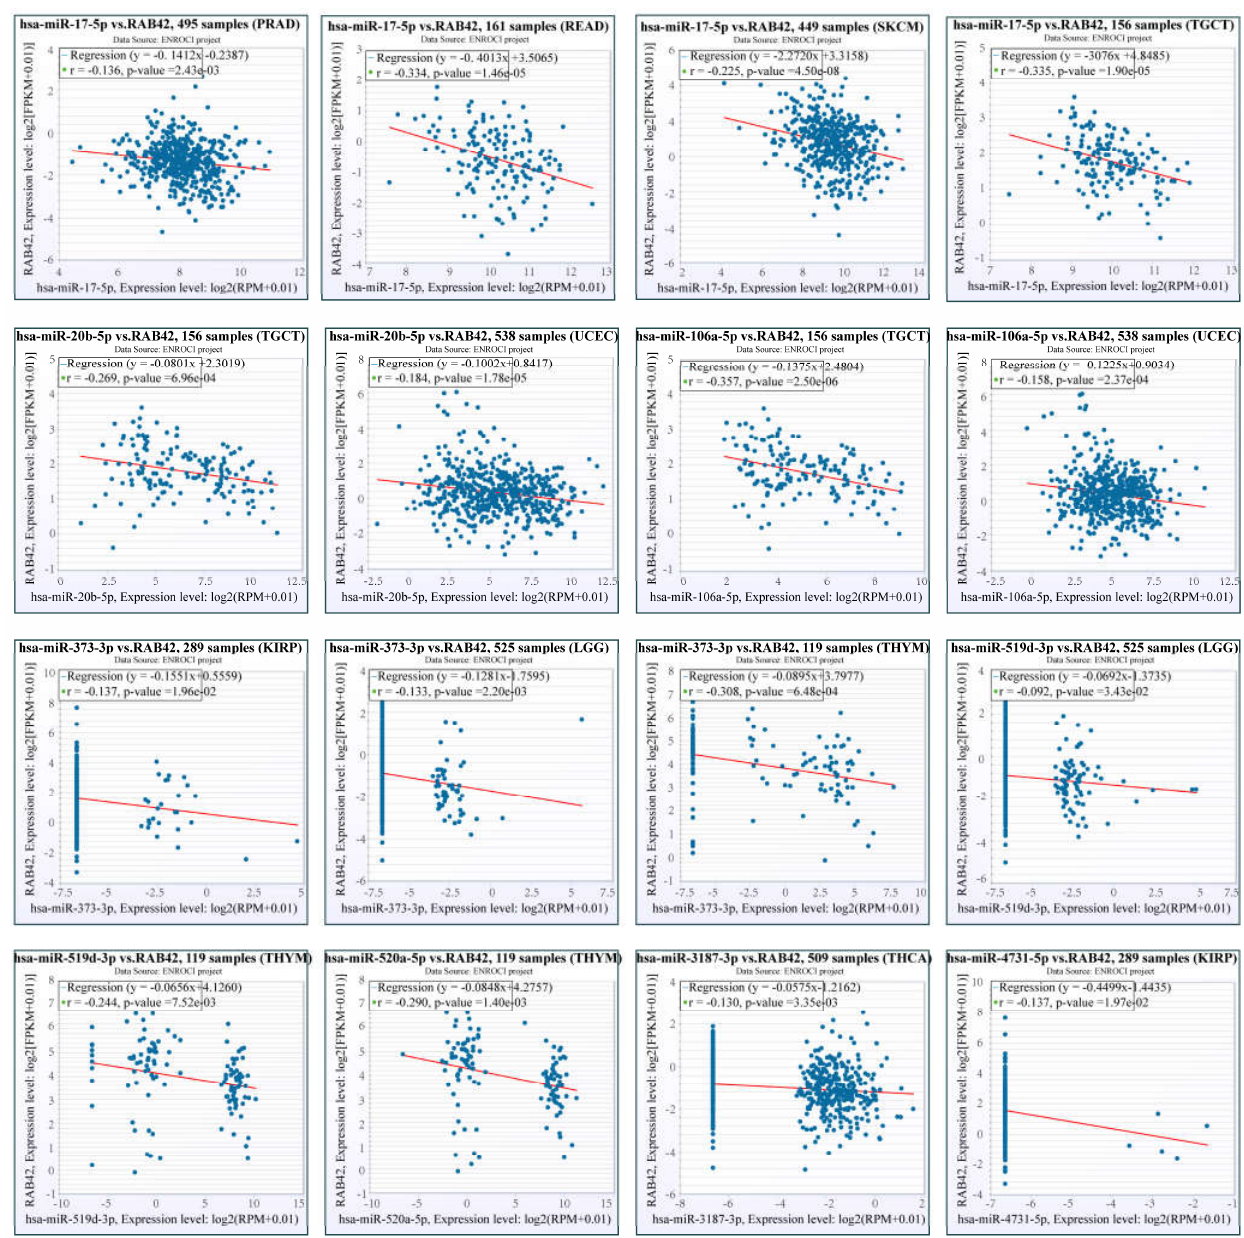
Figure 12. Co-expression analysis for the miRNA-RAB42 interactions.